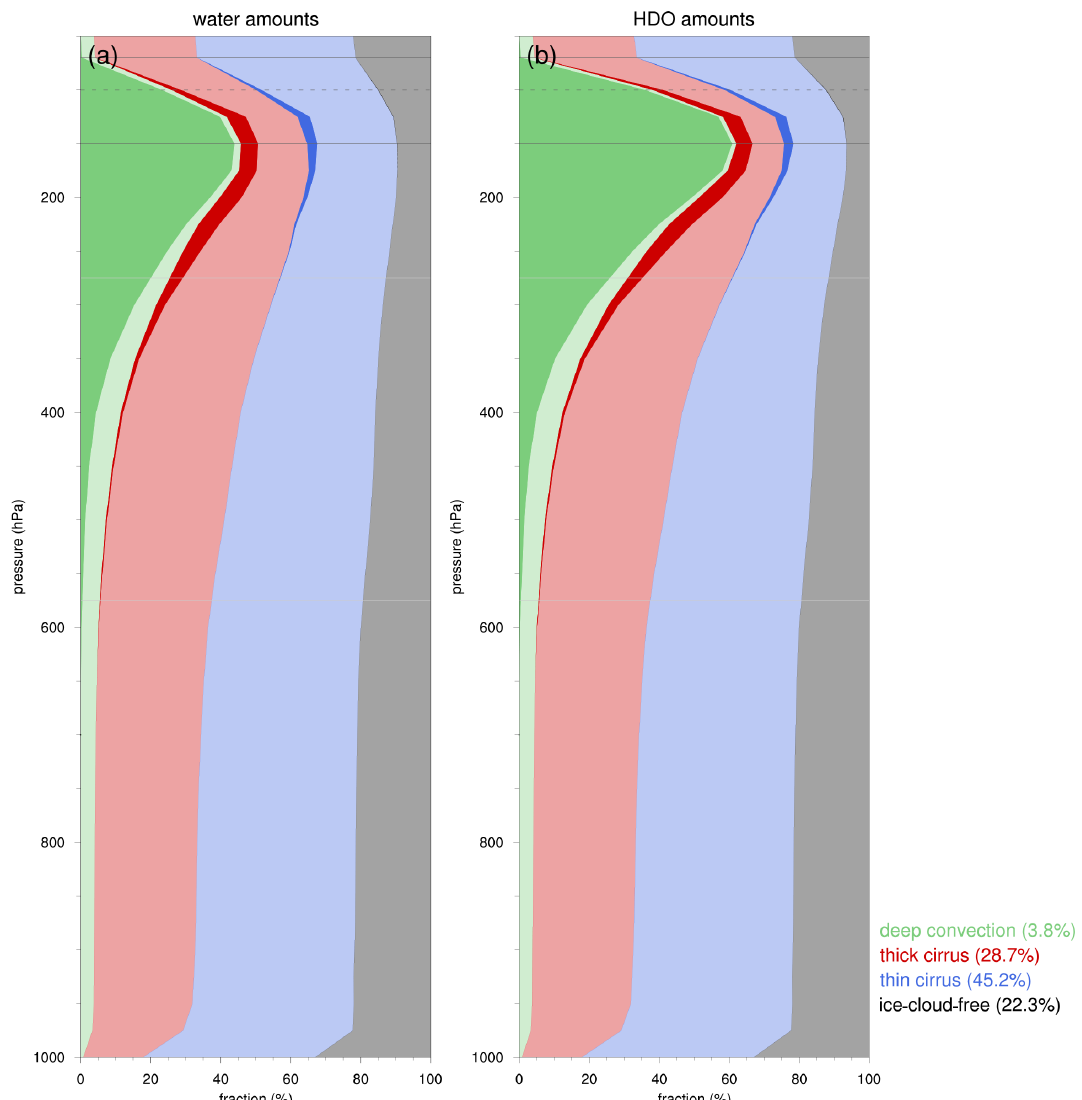
Figure 15. Total water amounts partitioned over the four ice cloud regimes in the region of interest in July 2016. The colours show the (a) total water and (b) total deuterated water (HDO) amounts within the four different ice cloud regimes, as indicated by the legend. Opaque colours represent water in the ice phase, and transparent colours represent water in the vapour and liquid phases. The numbers in the legend indicate the fractions of grid points in each of the different ice cloud